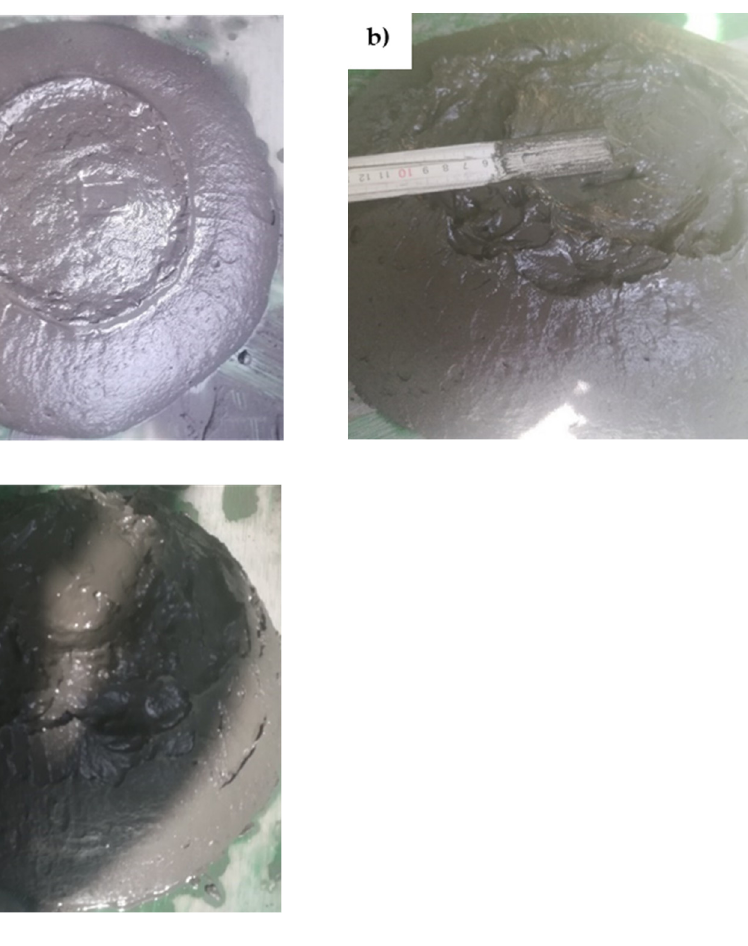
Figure 4. Slump consistency of CWTB at ( a ) 72 wt. %, ( b ) 74 wt. %, ( c ) 75 wt. % with 1 wt. % of binder dosage.